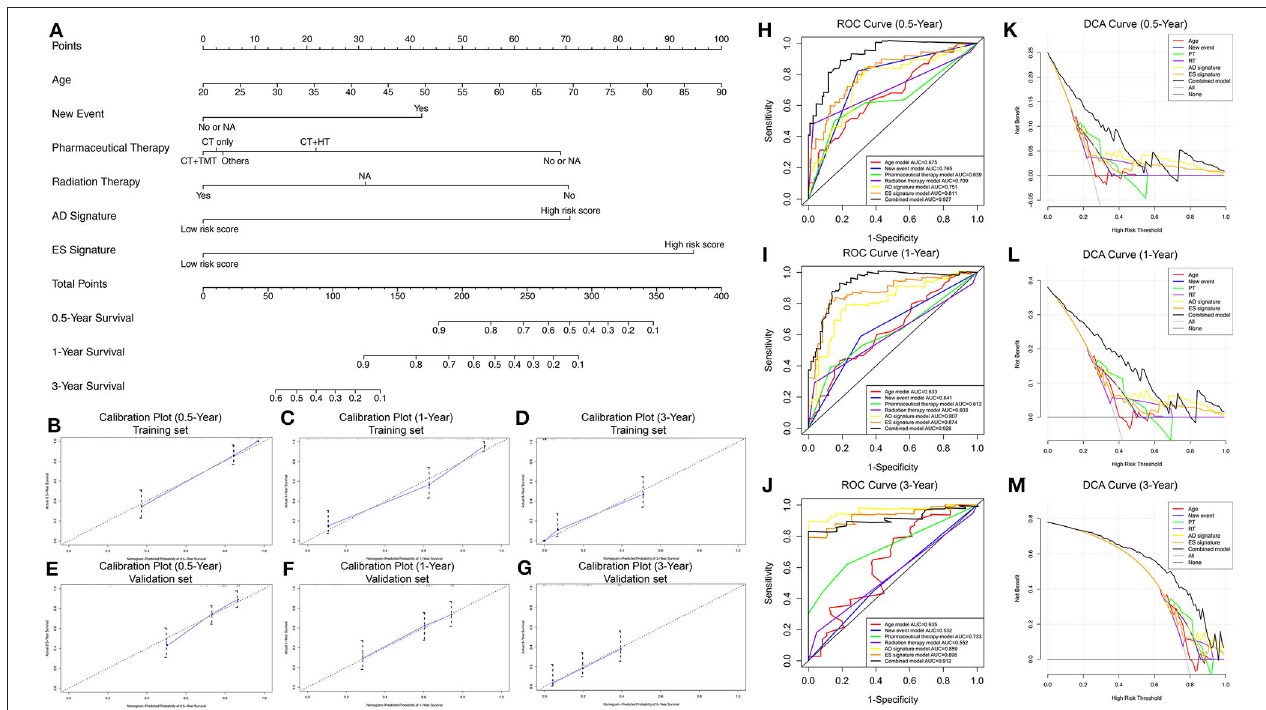
FIGURE 6 | Nomogram to predict the probability of 0.5-, 1-, and 3-year survival in GBM. (A) Prognostic nomogram to predict the survival of GBM patients. (B–D) Calibration plots for the nomogram to predict survival at 0.5, 1, and 3 years in the training set. (E–G) Calibration plots for the nomogram to predict survival at 0.5, 1, and 3 years in the validation set. Actual survival is plotted on the y-axis, and the nomogram-predicted probability is plotted on the x-axis. (H–J) The prognostic performance of the nomogram, demonstrated by the ROC curves for predicting 0.5-, 1-, and 3-year OS, compared with other single factor prognostic models. (K–M) The clinical benefit and the scope of applications of the nomogram, evaluated by the DCA curves at 0.5, 1, and 3 years. The net benefit is plotted on the y-axis, and the threshold probabilities of patients for 1-, 3-, and 5-year survival are plotted on the